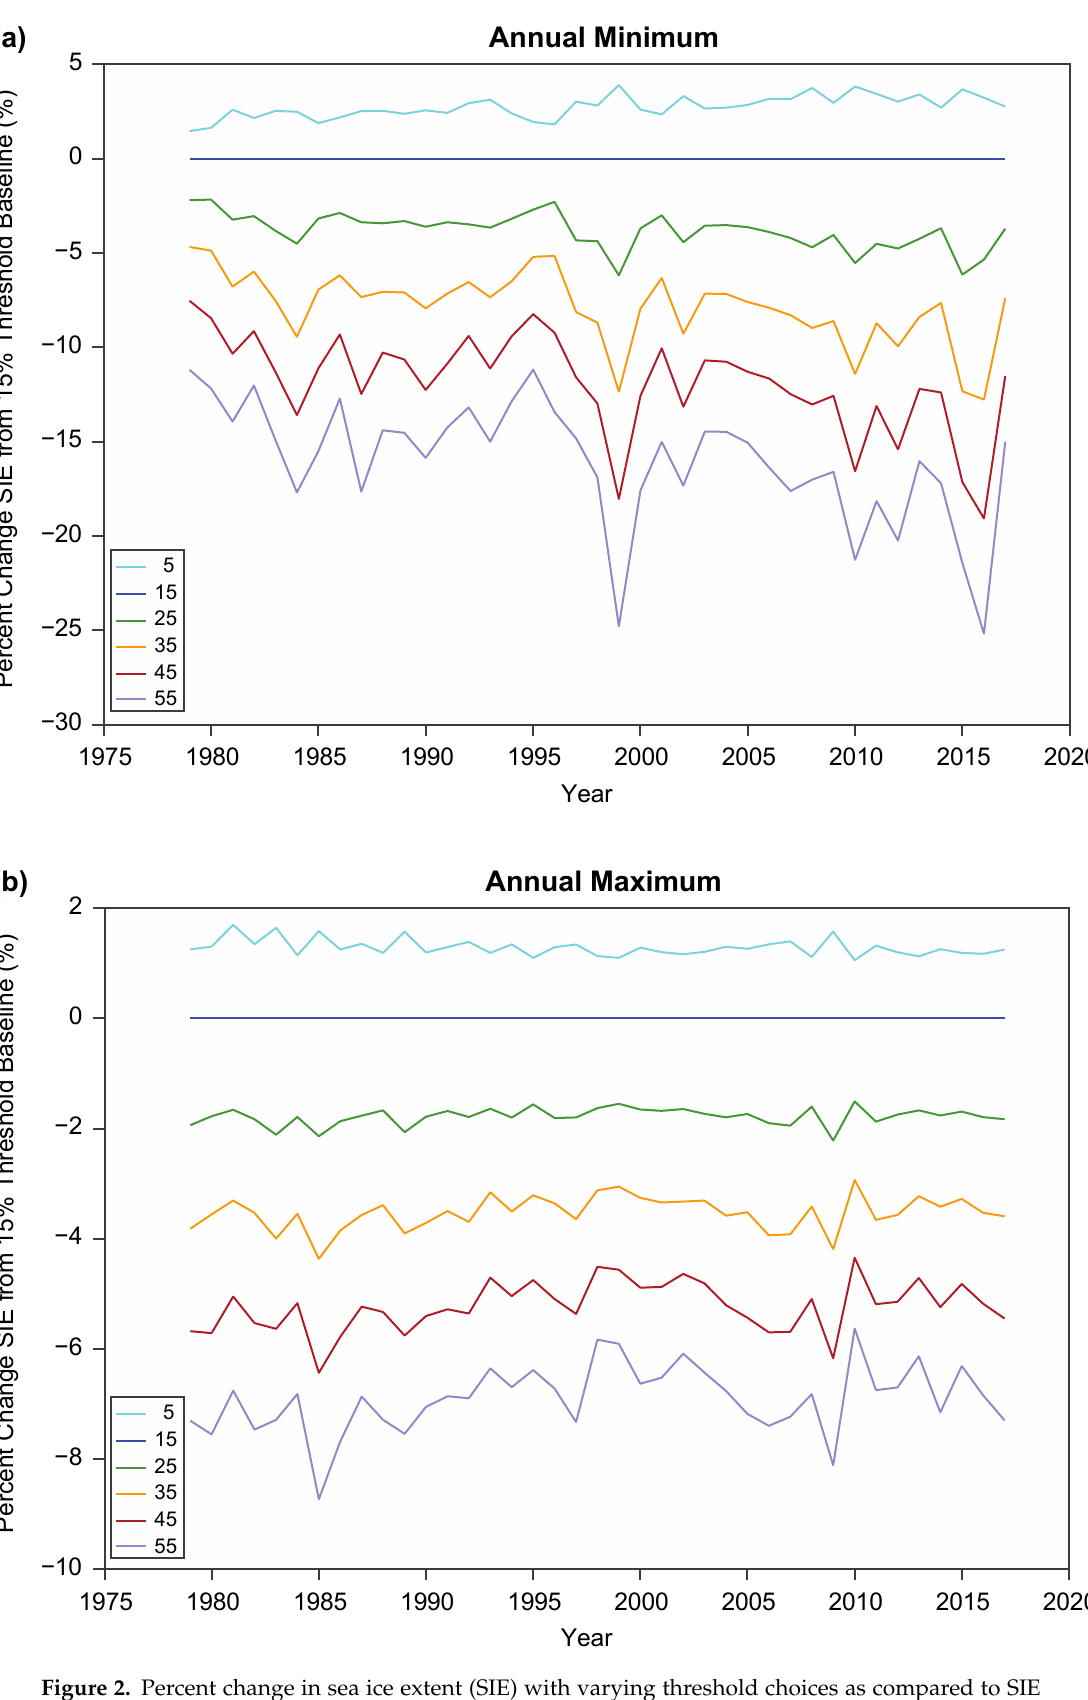
Figure 2. Percent change in sea ice extent (SIE) with varying threshold choices as compared to SIE calculated with the 15% threshold for annual SIE ( a ) minimums and ( b ) maximums.